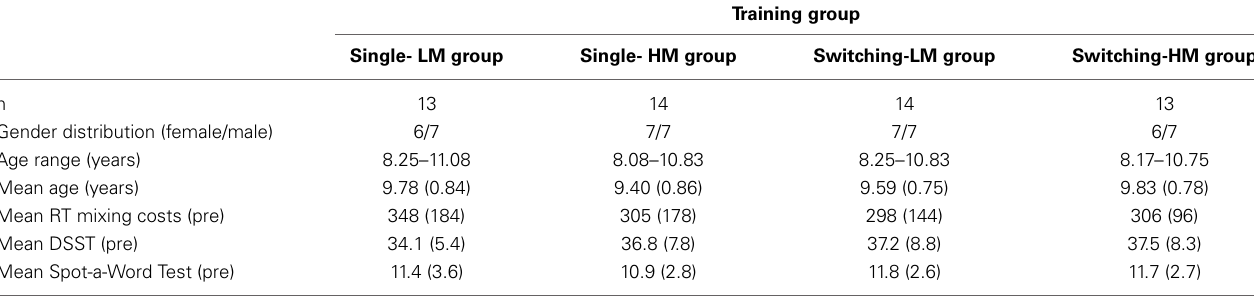
Table 1 | Descriptive statistics for the effective